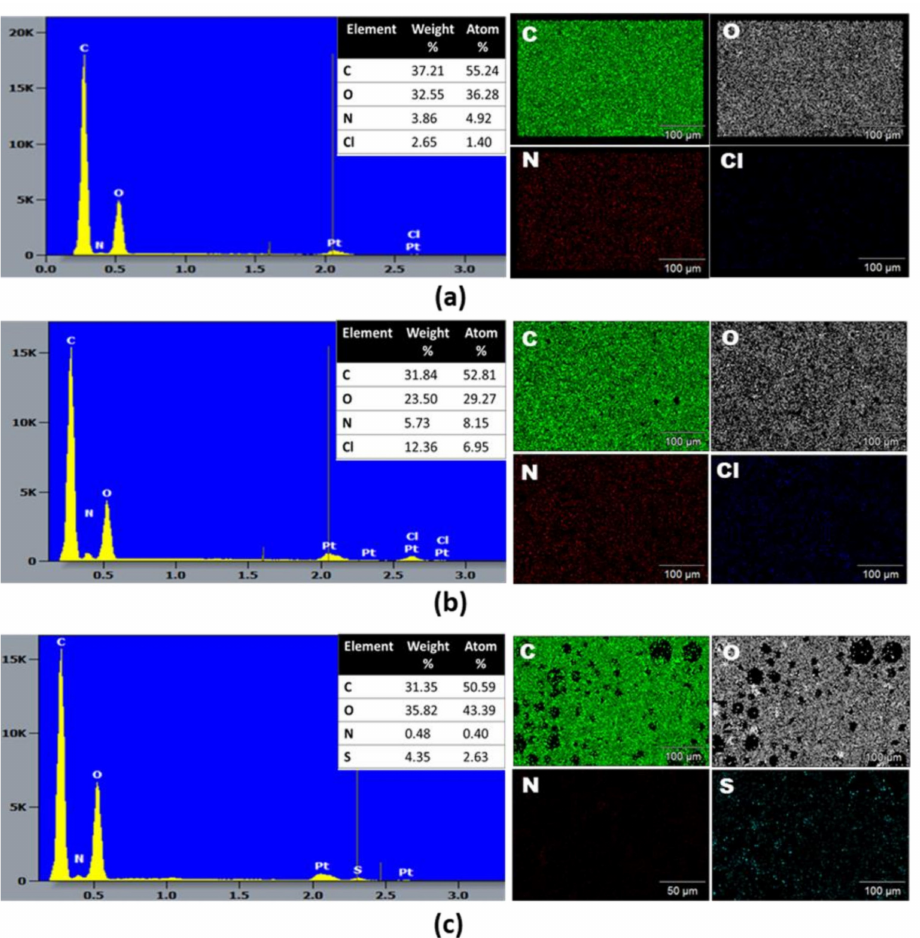
Figure 3. SEM-EDX and qualitative-quantitative elemental mapping analysis of ( a ) f-PANI, ( b ) HCP- PANI, and ( c ) HCP-SPANI films. All three films showed the presence of carbon (C), oxygen (O) and nitrogen (N), and additionally chlorine (Cl) for the f-PANI and HCP-PANI films, while the presence of sulfur (S) was observed in HCP-SPANI, confirming the doping of HCl and H 2 SO 4 ,